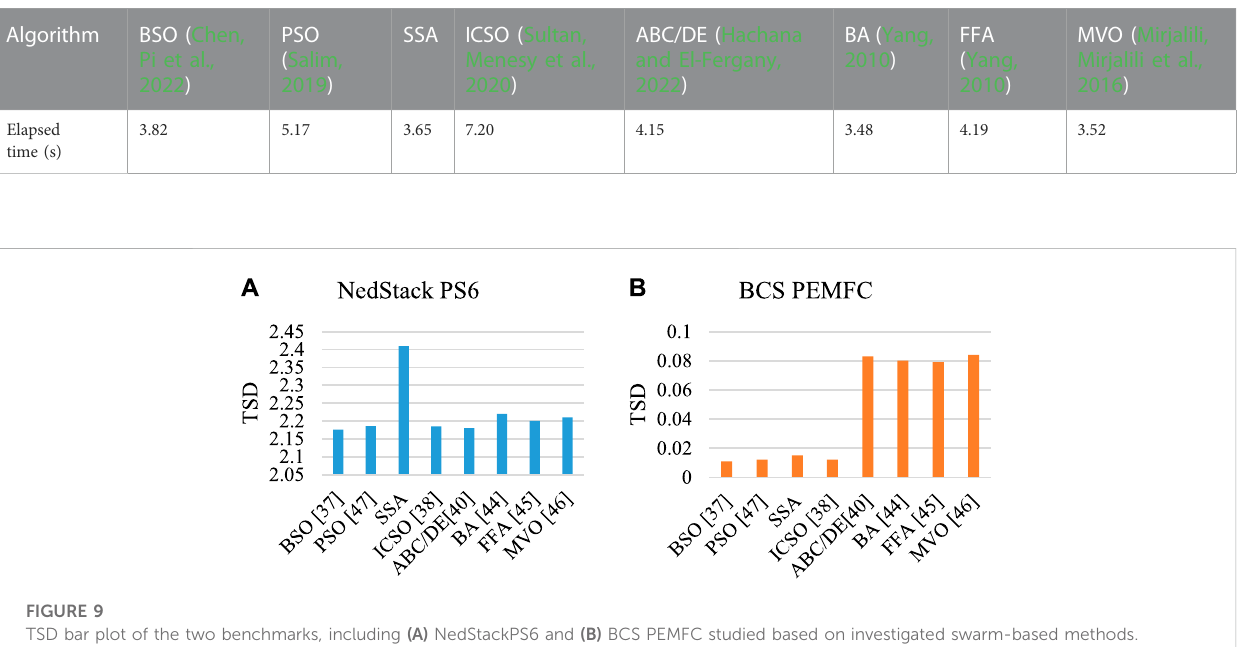
Figure 9 represents the TSD bar plot of the two benchmarks studied based on investigated swarm-based methods.